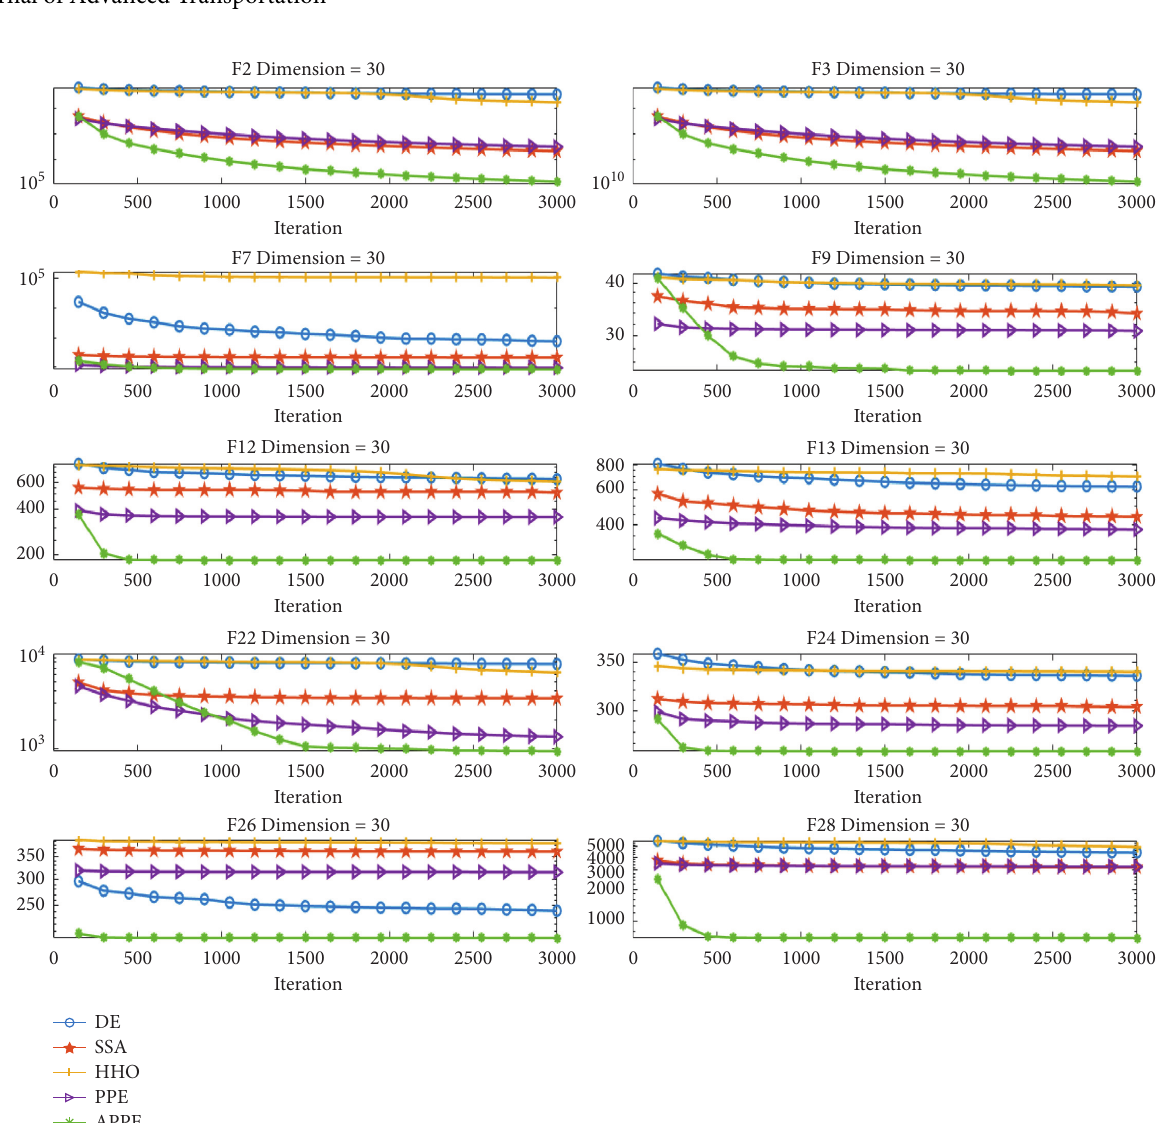
Figure 5: APPE’s convergence curve with the dimension of